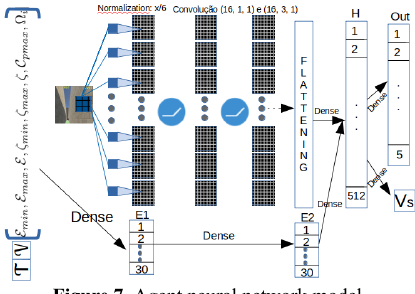
Figure 7. Agent neural network model.